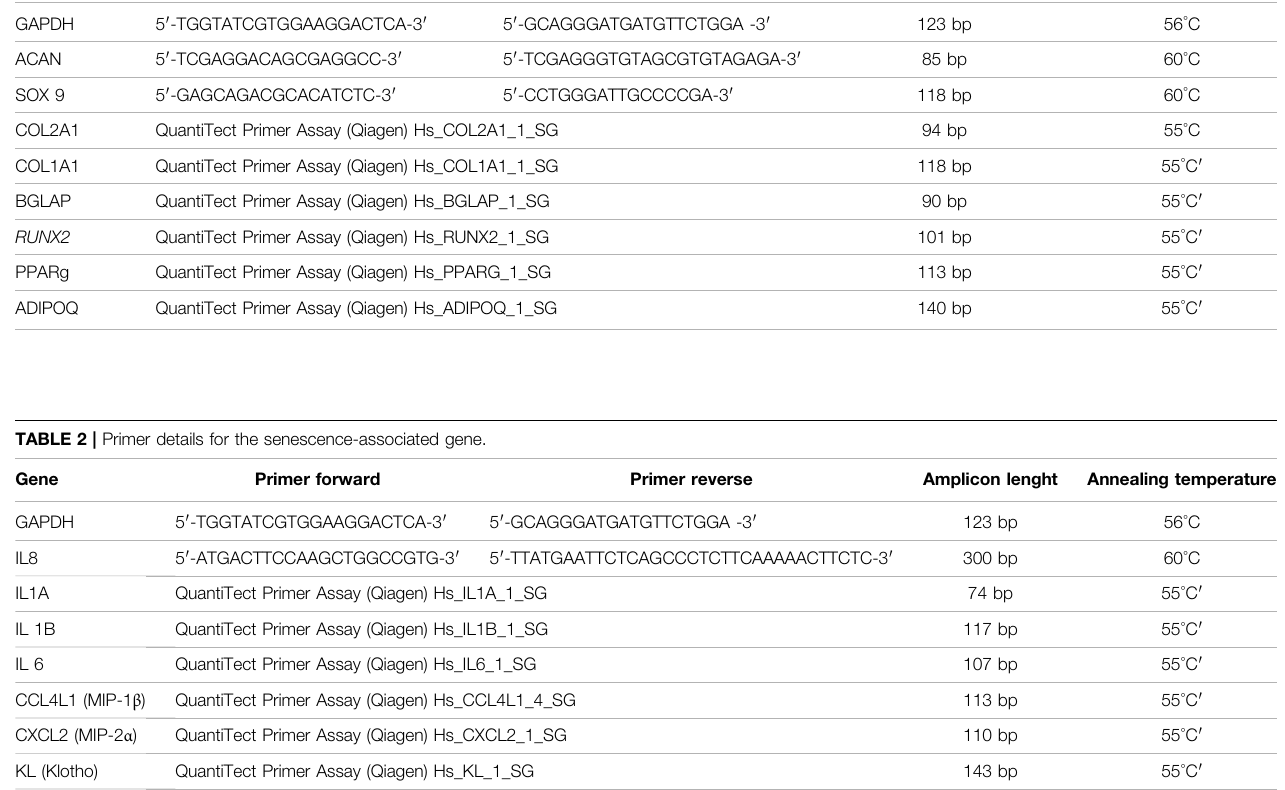
TABLE 1 | Primer details for osteo-, adipo-, and chondrogenic gene. Gene